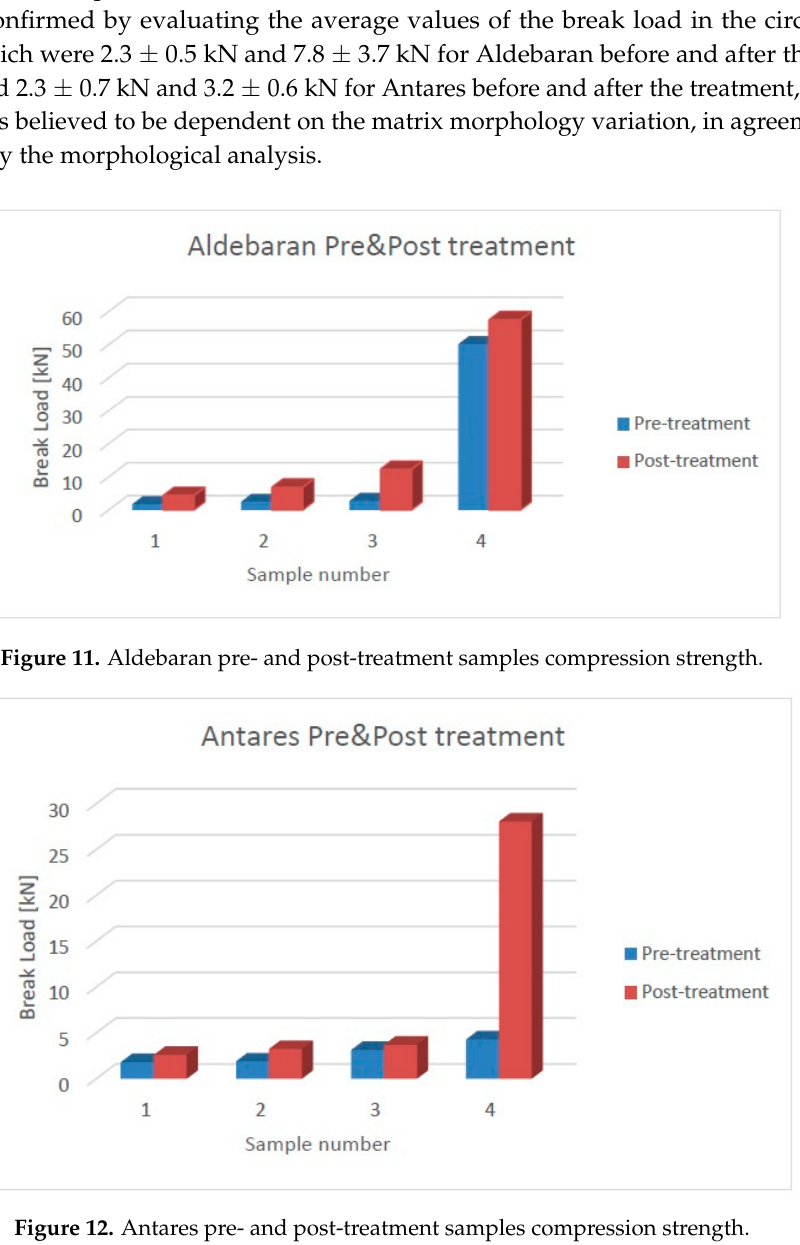
Figure 10. C/C thermal expansion coefficient before and after the stabilization cycle.